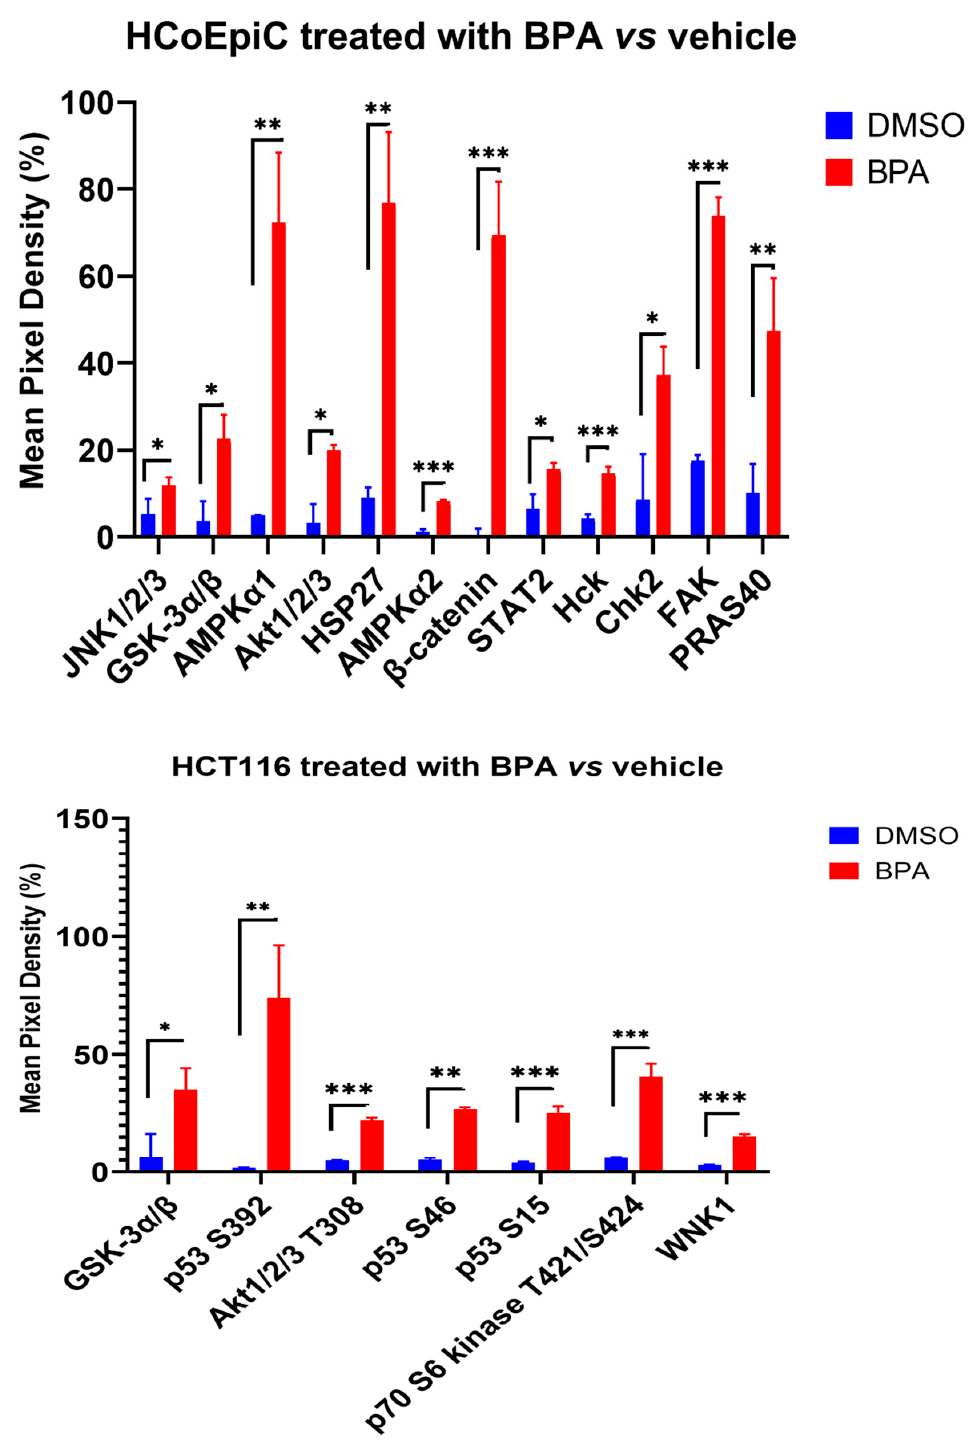
Figure 3. Phospho-kinase array analysis after exposure of the HCoEpiC and HCT116 cell lines to BPA for two months as compared to the vehicle (DMSO). Whole cell extracts were processed with the “human phospho-kinase array” ready-made kit. Data were analyzed using the “Image J” program and the means +/ − the SEMs of the pixel density were blotted (in relation to the positive control spot). Out of the 43 tested proteins, only the proteins which showed a significant increase in the test compared to the control (DMSO) are shown. The data shown are means ± SEMs, and * p < 0.05, ** p < 0.01, and *** p < 0.001, with n = 3.